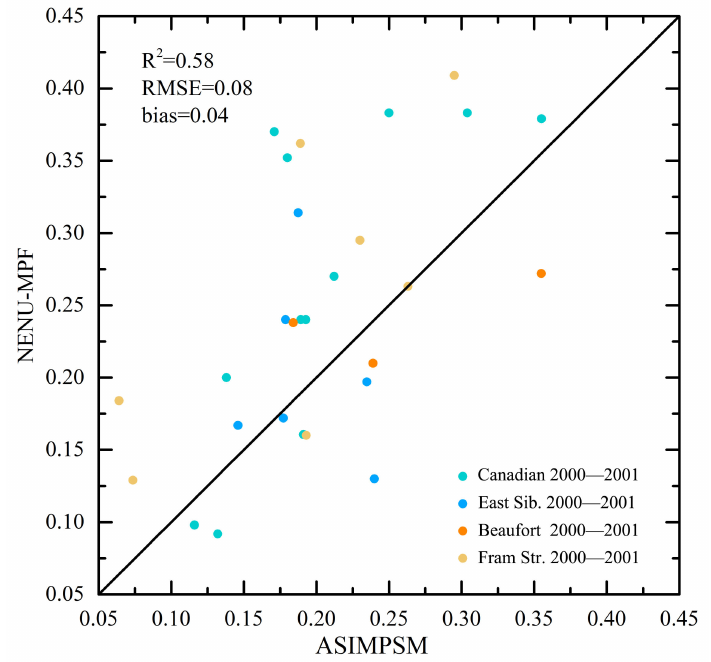
Figure 13. Validation of the NENU-MPF dataset against the ASIMPSM dataset.